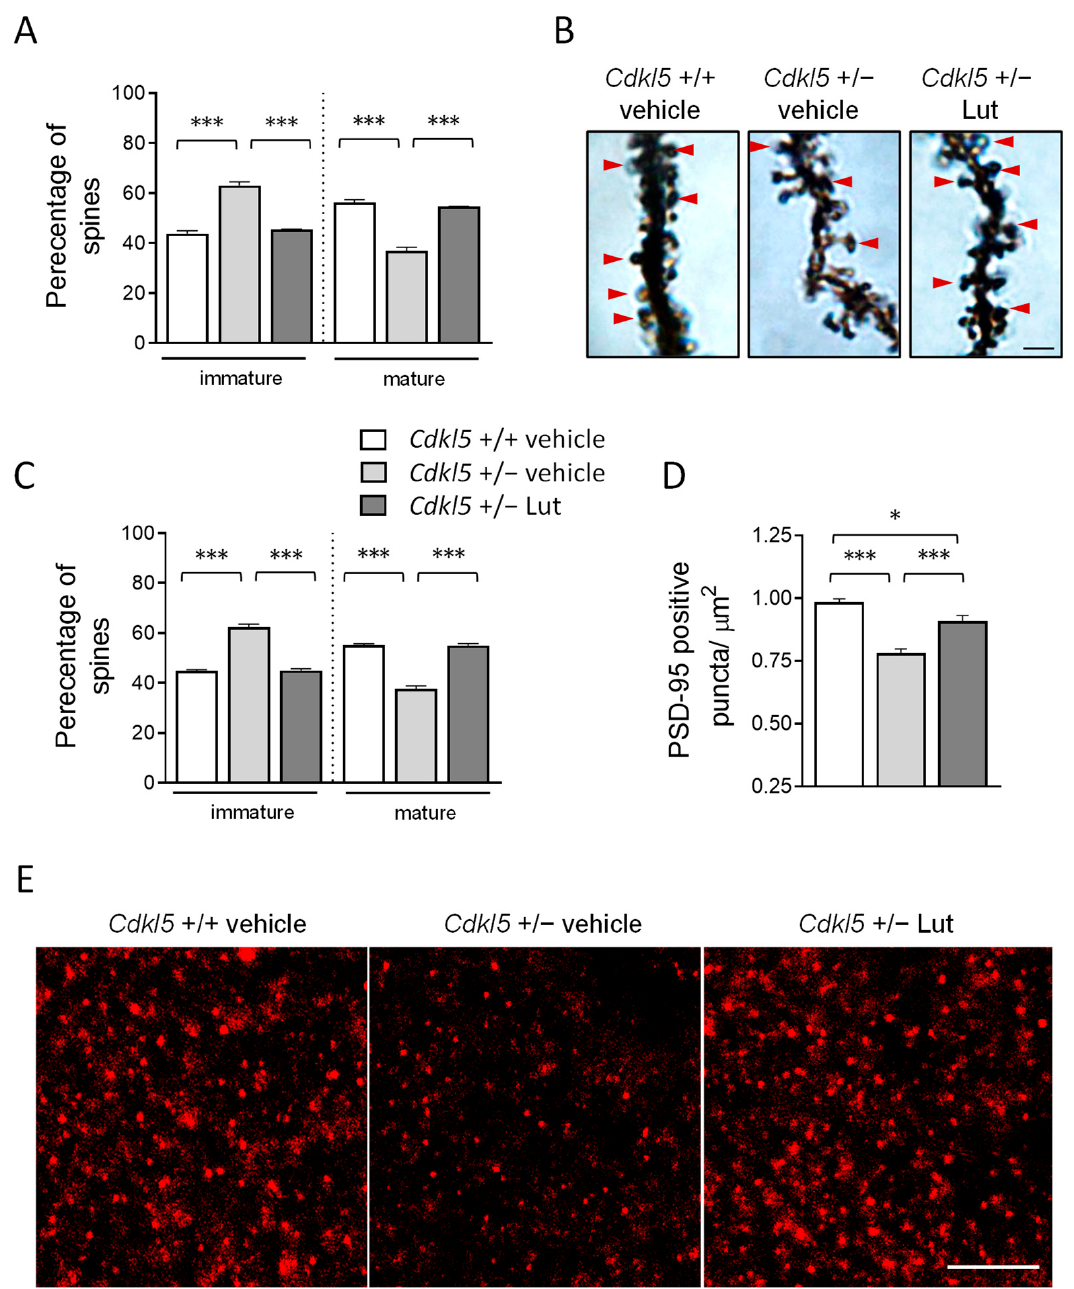
Figure 6. Effect of luteolin treatment on neuronal connectivity in Cdkl 5 +/ − mice. ( A , C ) Percentage of immature and mature dendritic spines in relation to the total number of protrusions in CA1 ( A ) and cortical ( C ) pyramidal neurons of vehicle-treated Cdkl 5 +/+ (n = 4) and Cdkl 5 +/ − (n = 4) mice and luteolin-treated Cdkl 5 +/ − (n = 4) mice. ( B ) Examples of Golgi-stained hippocampal pyramidal neurons of one animal from each experimental group; red arrows represent mature spines. Scale bar = 2 µm. ( D ) Number of fluorescent puncta per µm 2 , exhibiting PSD-95 immunoreactivity in the CA1 layer of the hippocampus of vehicle-treated Cdkl 5 +/+ (n = 4) and Cdkl 5 +/ − (n = 4) mice and luteolin-treated Cdkl 5 +/ − (n = 4) mice. ( E ) Representative fluorescence image of PSD-95 immunoreactive puncta in the hippocampus of one animal from each experimental group. Scale bar = 6 µm. Values are represented as means ± SEM. * p < 0.05, *** p < 0.001. Fisher’s LSD test after two-way ANOVA.